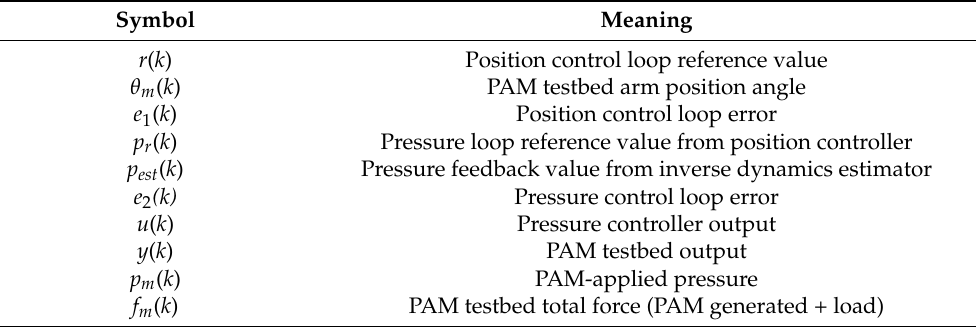
Figure 6. Block diagram of proposed adaptive nonlinear control system. Table 3. Symbols used in proposed control system block diagram.